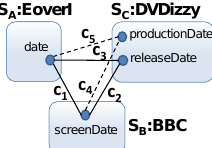
Figure 1. A matching network of real-world schemas even come from malicious users (for example, from those who just want to obtain the financial compen- sation for the task without providing useful